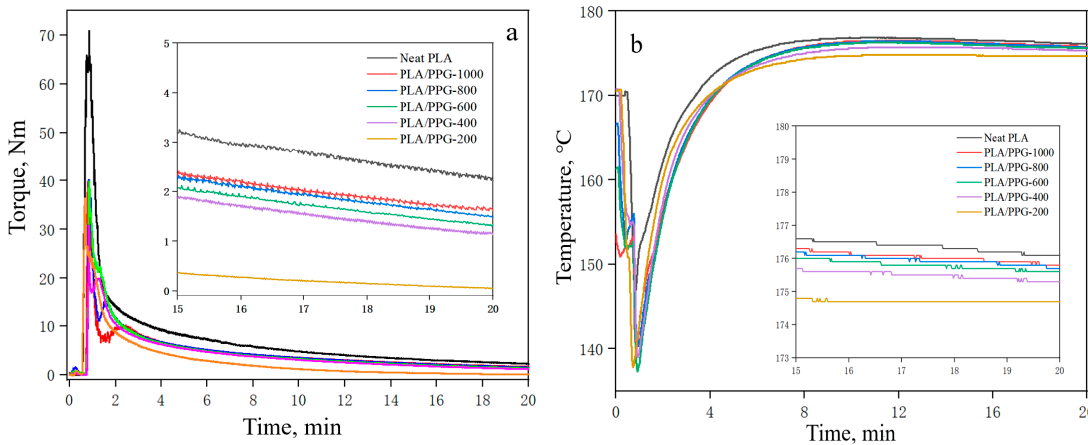
Figure3. Torque( a )andtemperature( b )versustimewhenprocessingtheneatPLAandPLA /